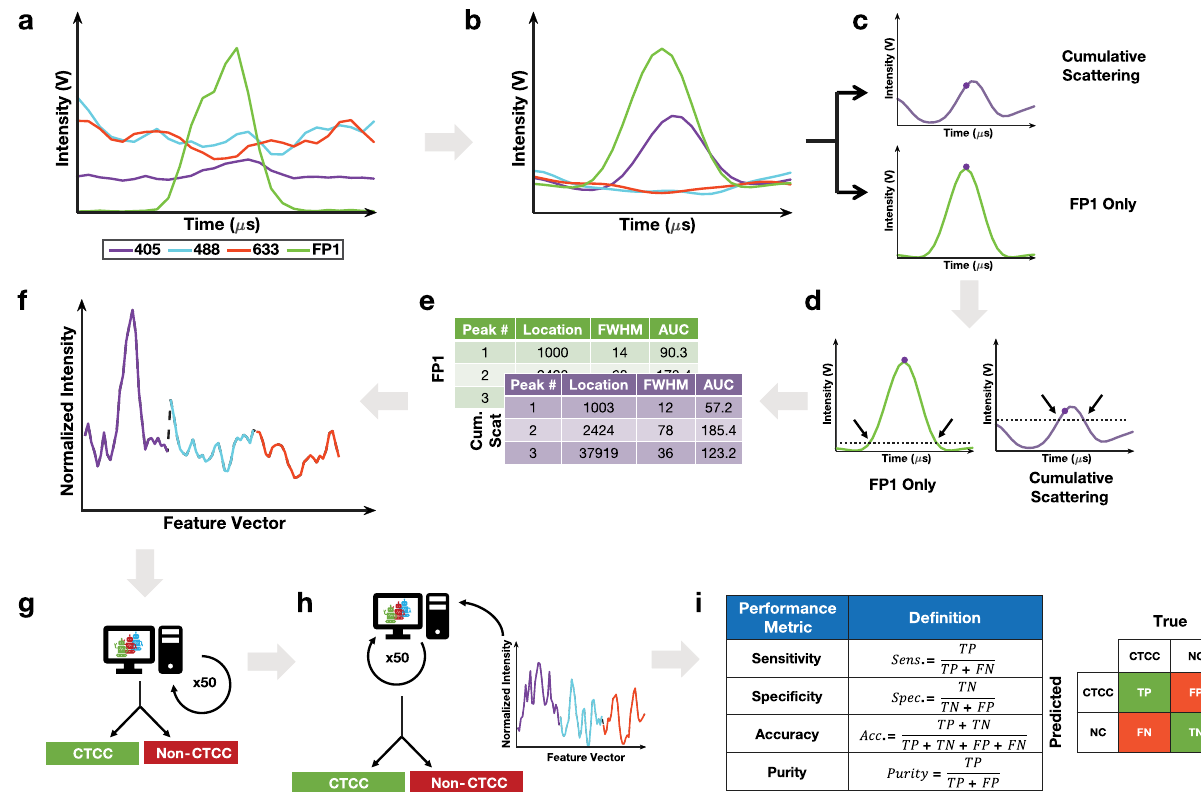
Figure 3. Machine learning model workflow. ( a ) Collected scattering and fluorescence data were analyzed to find the location of all cluster events. FP1 represents GFP used for ground truth labeling. ( b ) Data were initially normalized using power measurements and a second order Butterworth filter. ( c ) Data from FP1 was processed separately from the cumulative scattering data (405 + 488 + 633). The built in findpeaks.m function was used to find all local maximums in the 1.5-min data traces in both FP1 only and cumulative scattering data sets. ( d ) An intensity threshold was used to define the start and end of a peak. The threshold value was defined as being three times the standard deviation of the entire 1.5-min data trace in the FP1 and cumulative scattering channel. ( e ) Peak locations and characteristics were recorded for both the ground truth (FP1) data and the cumulative scattering data. ( f ) Using the locations of these clusters, a window of ± 13 points per scattering channel were reorganized into an 81-point feature vector. Based on FP1, we generated the labels for peaks as either being CTCC and NC events. ( g ) The generated features and labels were used to train a Gentle Adaptive Boost, Ensemble Boosted Tree classification algorithm to classify peaks. The training set included measurements from 10 days of collections while the test set was composed of 5 separate days of data. The final model was an ensemble of 50 models trained on fifty different data sets composed of the same CTCC peaks and an equal number of randomly selected NC peaks. ( h ) The test set was evaluated following training and used to classify peaks based on similarly formatted feature vectors (pseudocode can be found as Supplementary Fig. S1). ( i ) Performance metrics were calculated based on test set